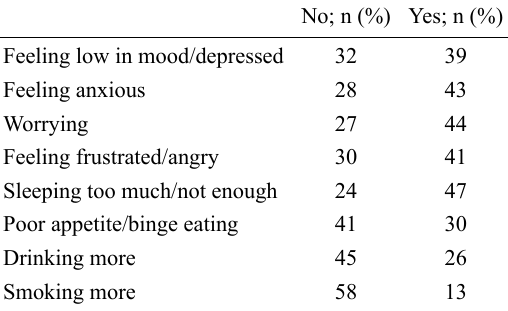
Table 8. The impact of SARS-CoV-2 related changes and stressors on mental health and behavioural outcomes among staff; frequencies and percentages.